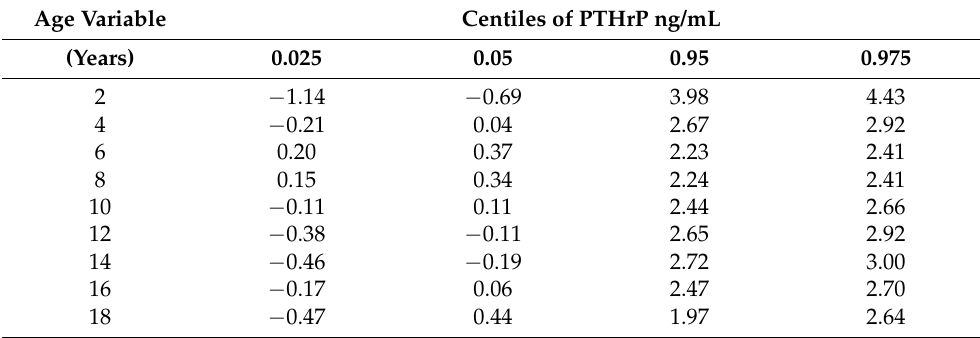
Table 2. An age-related reference interval. A stratification in 9 age groups and a range of PTHrP